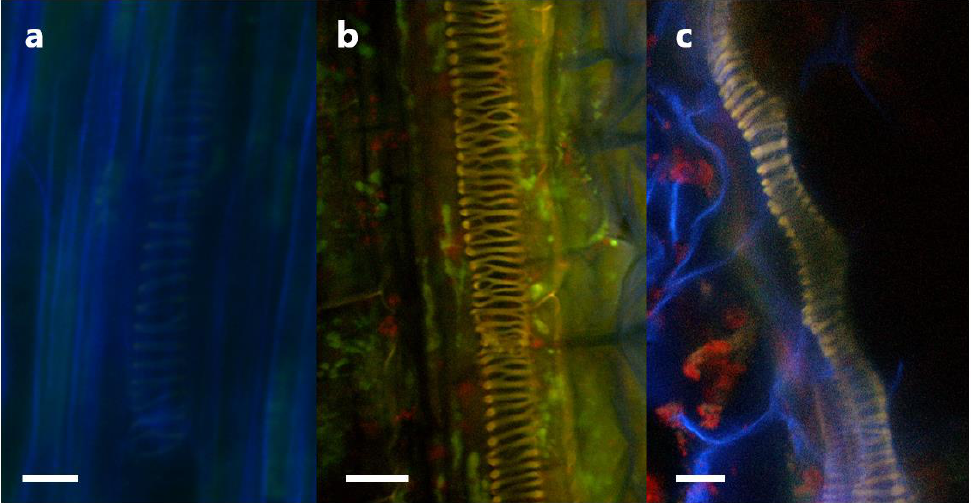
Figure 15. DNA and mCherry in the xylem of P3AW: mCherry inoculated clover plants. ( a ) Root xylem of an uninoculated plant. ( b ) DNA and mCherry in the root xylem of an inoculated plant. ( c ) DNA and mCherry in the cotyledon xylem of an inoculated plant. Scale bar = 15 µ m.